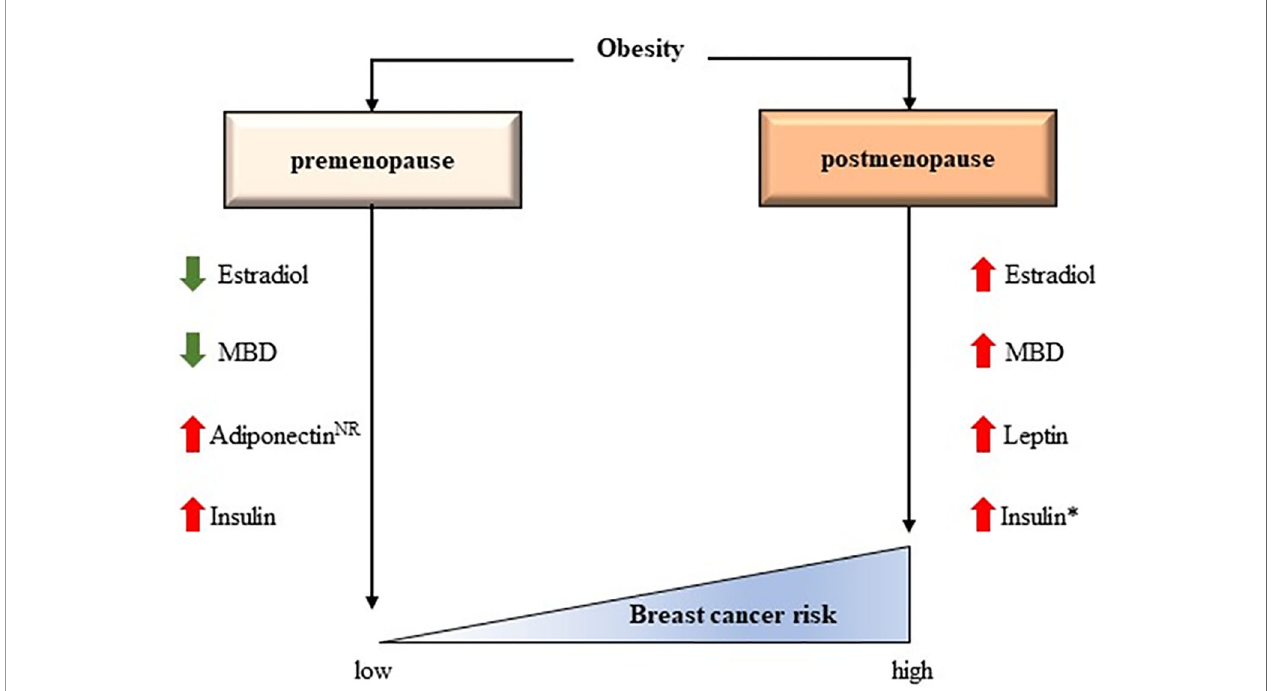
FIGURE 2 | The controversial effects of obesity according to menopausal status. Some interactions have been con fi rmed while others have been hypothesized. MBD, Mammogram breast density; NR, Not clearly reported. *The effect of insulin in breast cancer risk could be independent of BMI